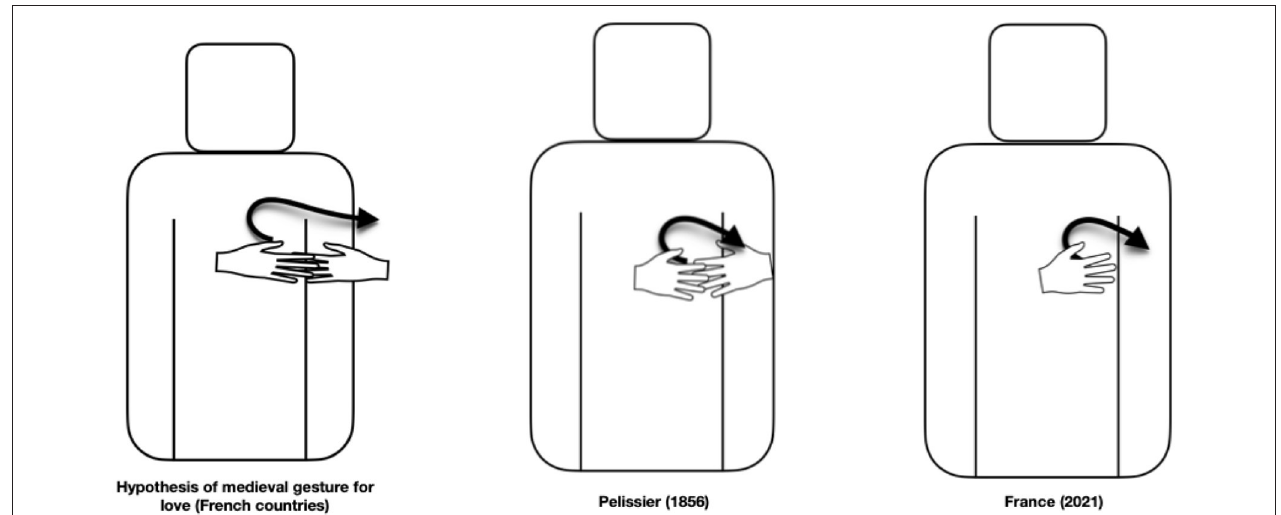
FIGURE 2 | The origins of the sign Love in LSF. This sign is specific to France and its cultural influence on French Sign Language and differs from the American Sign Language (ASL) sign for “Love.” It’s represents the gesture of the heart (or flowers) giving to somebody. This is a French cultural representation. So, in the first schema. we see two hands to move. This is the hypothesis representation of a medieval sign of love from. an 1100’s pictural representation of love (Link here for example of representation: https://journals.openecition.org/cem/17049) in the second, this is the 1856 sign from Pelissier dictionary. And the third, the modern sign in France. We see the cultural link since the Middle Ages period and his cultural and visual representations. The explanations of Desloges in his book give us a better understand of the French sign language